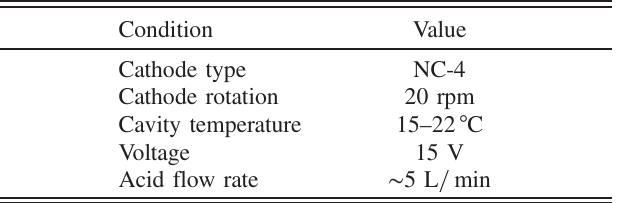
TABLE II. Initial VEP conditions applied to the nine-cell cavity